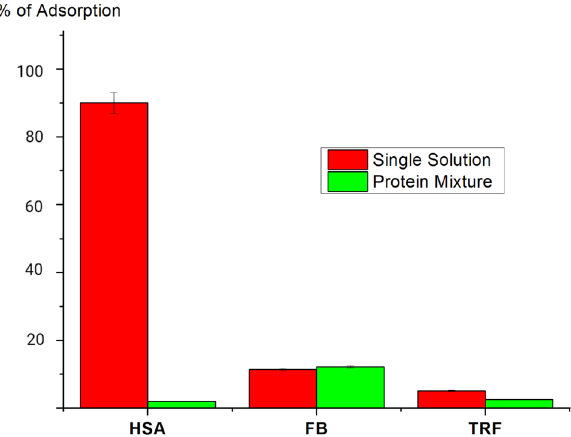
Figure 10. Comparison of adsorption ratio* of each protein from its single solution and protein mixture (* the mass of adsorbed protein divided by the total mass of all protein adsorbed ×